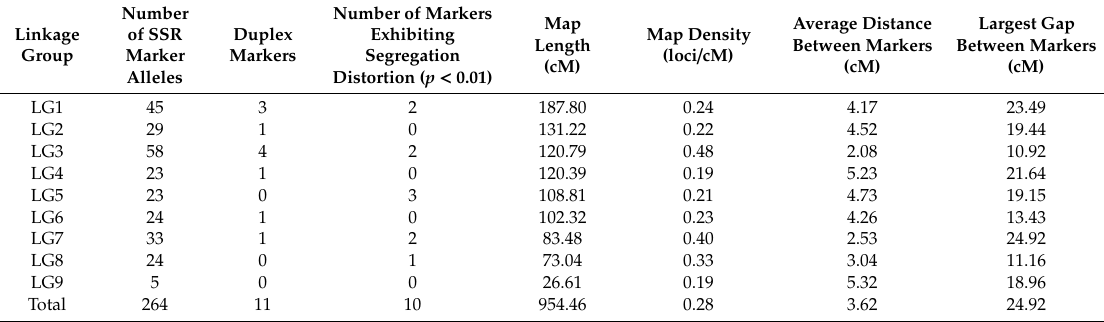
Table 2. Distribution of markers on the final integrated map and linkage group